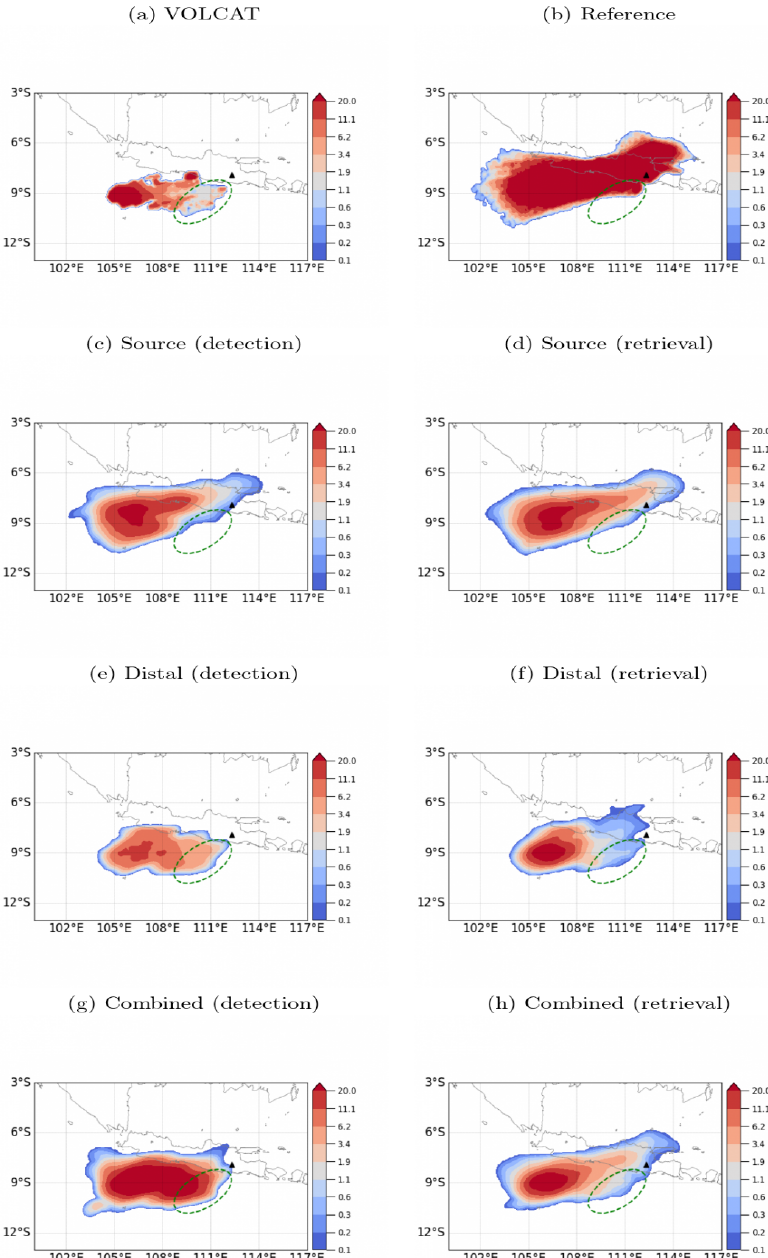
Figure 5. Mass load fields (in g/m 2 ) in the 13 February 2014 Kelut eruption case study at 14/0130 UTC for ( a ) VOLCAT retrieval, ( b ) reference run, ( c ) cylindrical source run with detection-based optimization, ( d ) cylindrical source run with retrieval-based optimizations, ( e ) distal source run with detection-based initialization and optimization, ( f ) distal source run with retrieval-based initialization and optimization, ( g ) hybrid source run using detections, and ( g ) hybrid source run using retrievals. The fields in ( b – h ) are ensemble means. The dashed lines indicate a region of interest discussed in the text. There is a region in the retrievals (indicated by the dashed lines) that is not cap- tured by the simulation in either the reference or SRC runs. Using the distal